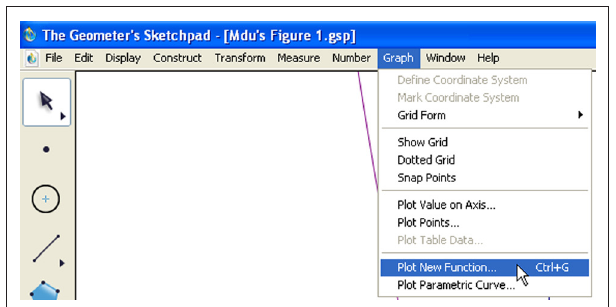
FIGURE 5: Example of commands in the Sketchpad drop-down